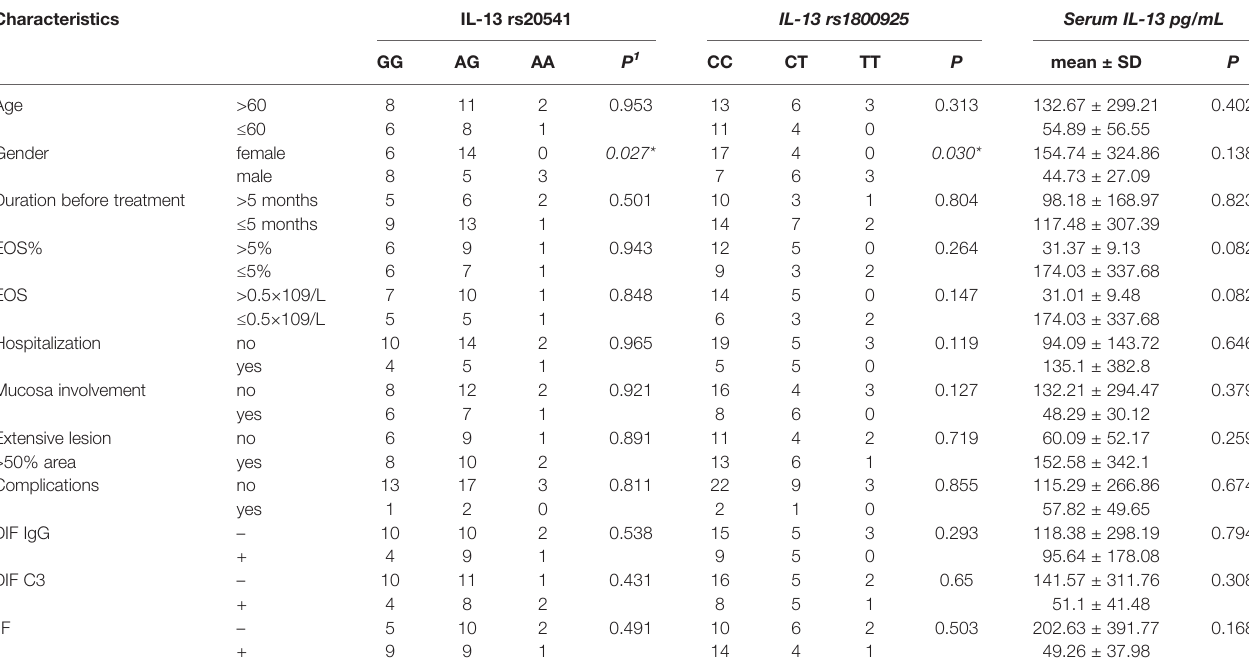
TABLE 3 | Correlation of the IL-13 genotypes and IL-13 serum levels with clinical characteristics and demographic data in BP patients. Characteristics